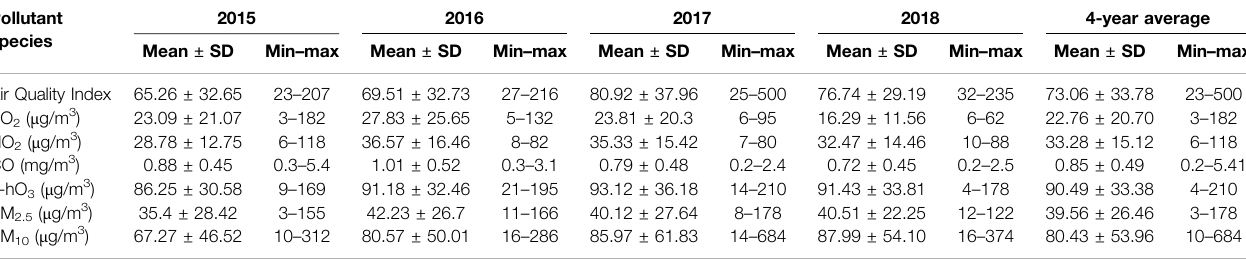
TABLE 1 | Statistical summary of Air Quality Index and six criteria pollutants during 2015 – 2018.